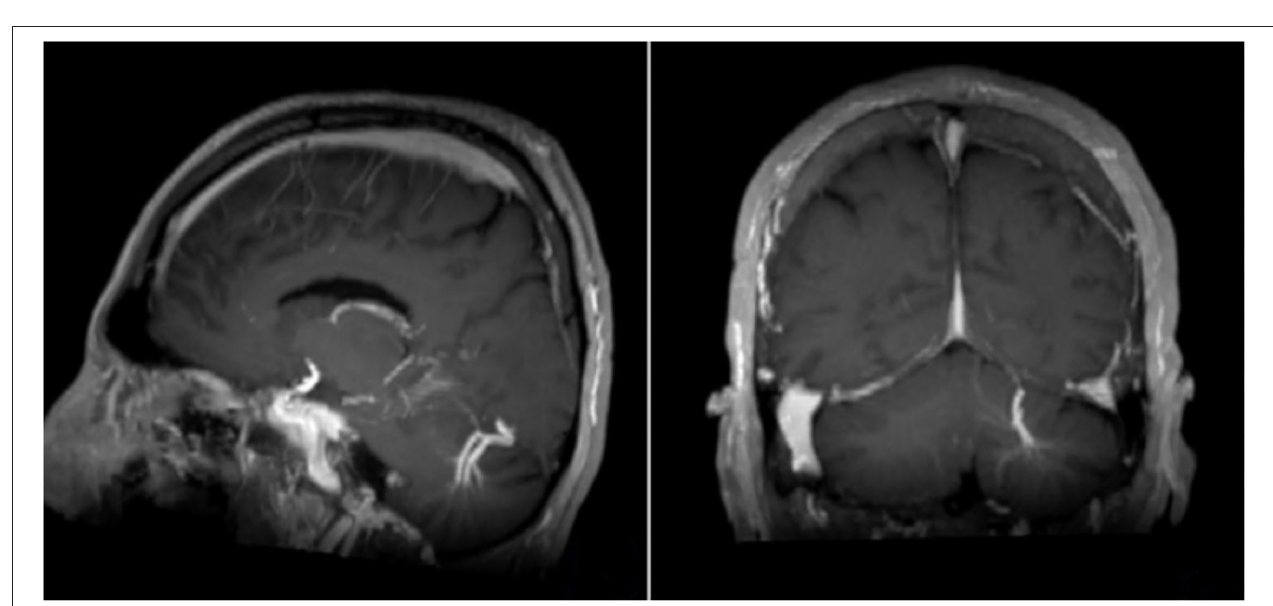
A higher proportion of CIS / MS patients than controls showing DVA might also have been caused by the lower slice thickness of 2 mm that was used when scanning patients compared to the regular 5 mm slice thickness used for controls although this should not have had a major impact given the generally larger size of